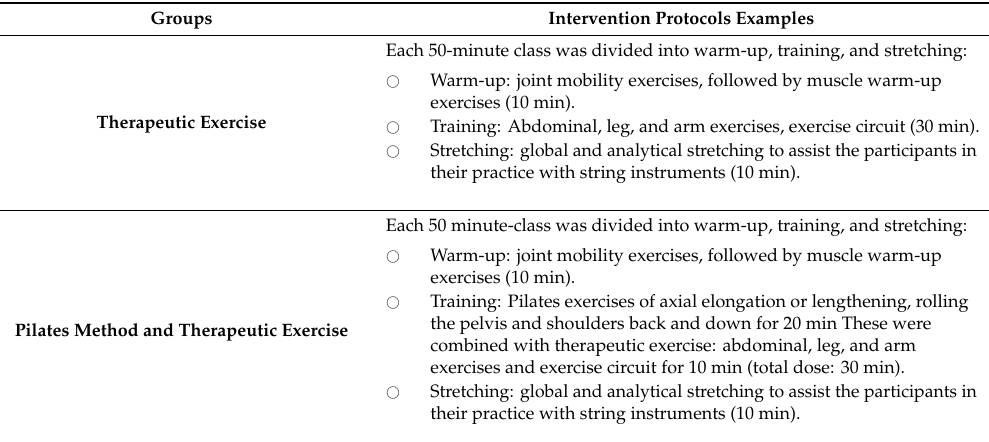
Table 1. Intervention protocols design.